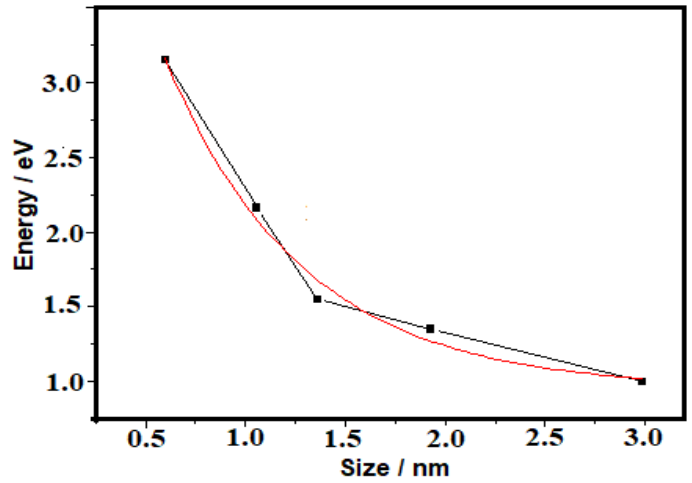
Figure 5. Change curve of bandgap energy with various diameter of Si NW, in which the black curve describes the simulating result and the red curve is fit one.